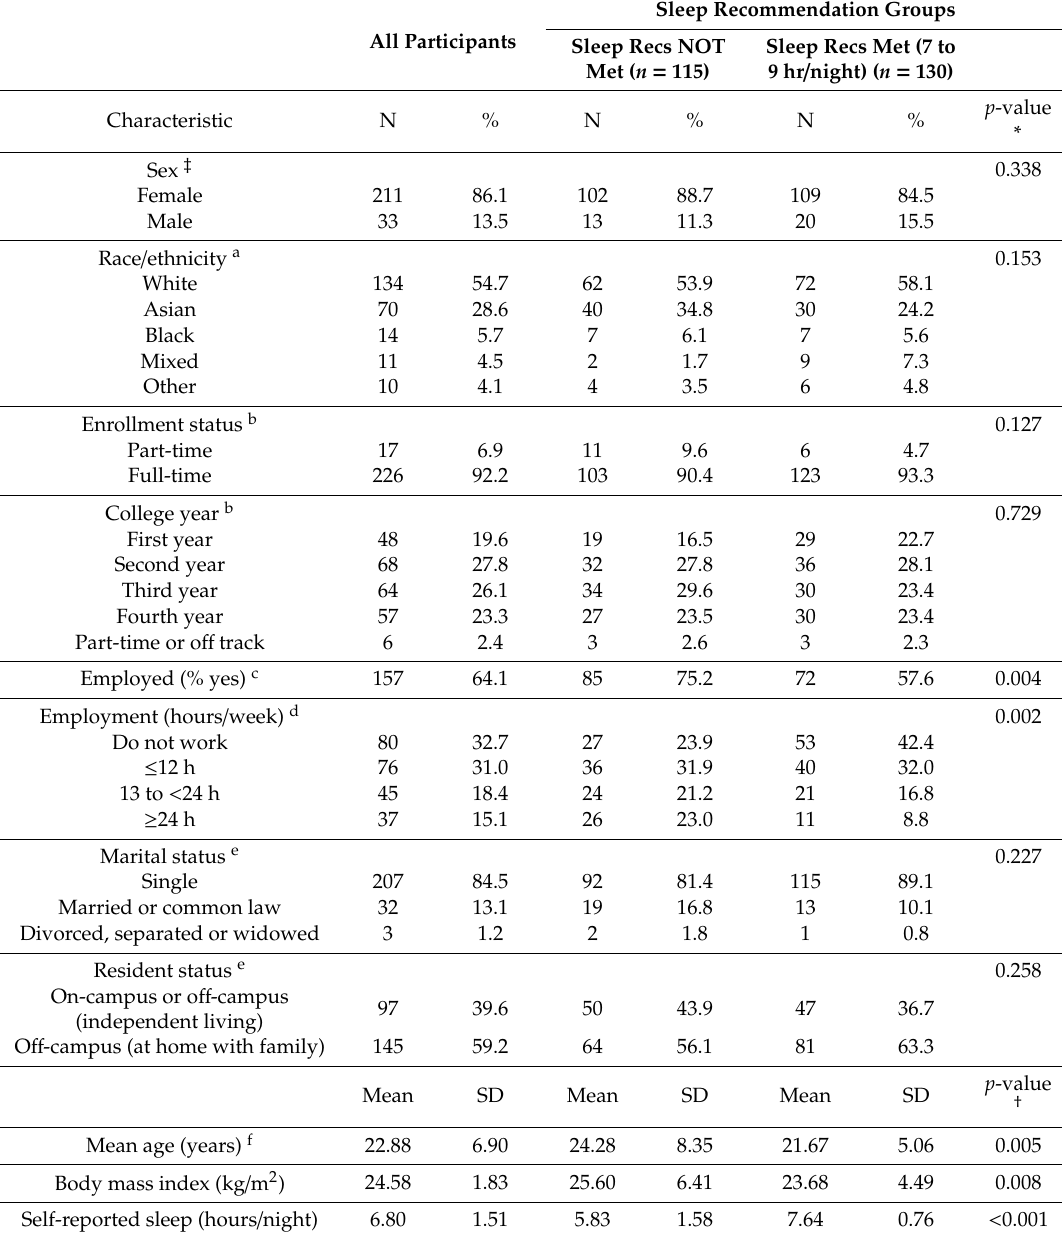
Table 1. Sociodemographic and health characteristics among Canadian college students ( N = 245).